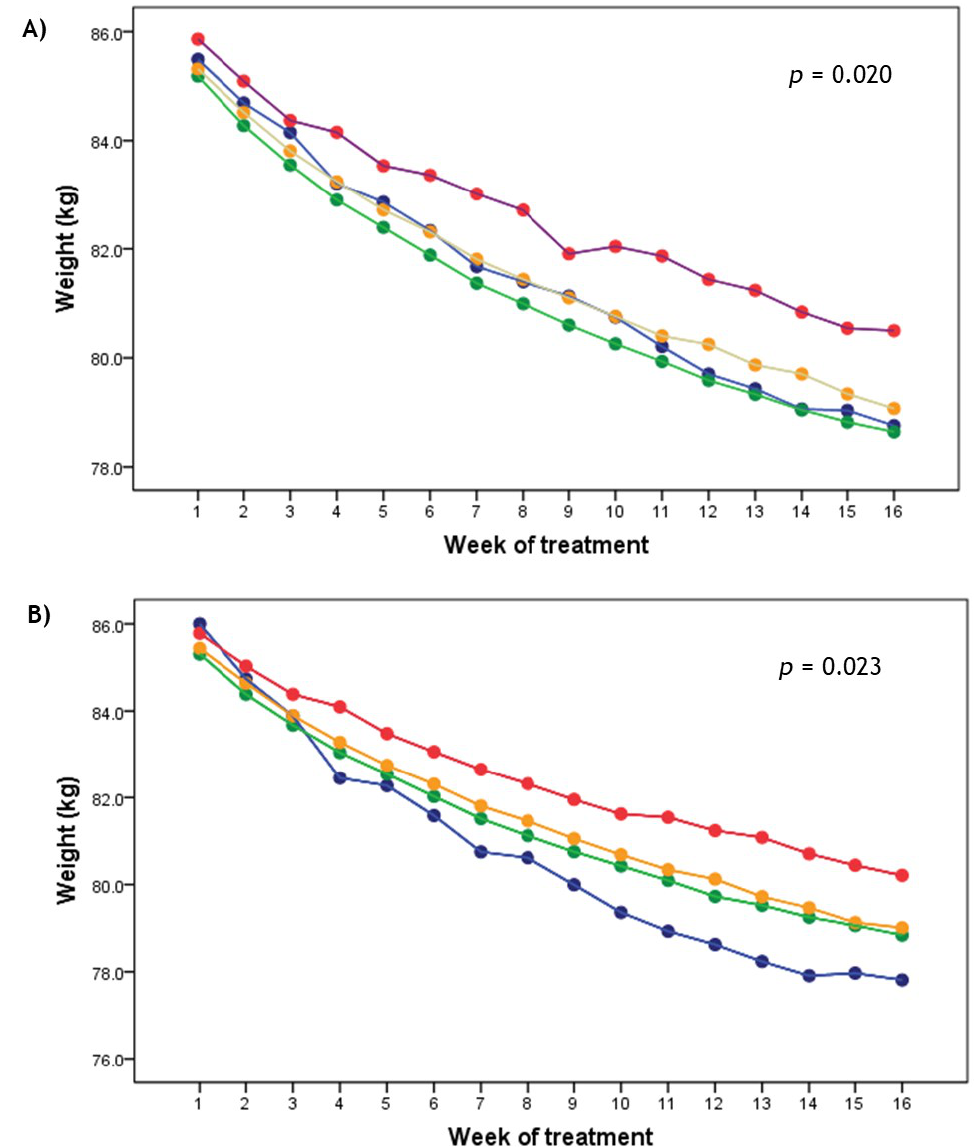
Figure 2. Total weight loss evolution by categories of obesity grade in infancy ( A ) and childhood ( B ) during treatment. A repeated-measures analysis of variance (ANCOVA) was performed. Analyses were adjusted for sex, age, nutritional clinic, year of assessment, and initial body weight. Blue line = underweight; green line = normal weight; yellow line = overweight; red line =